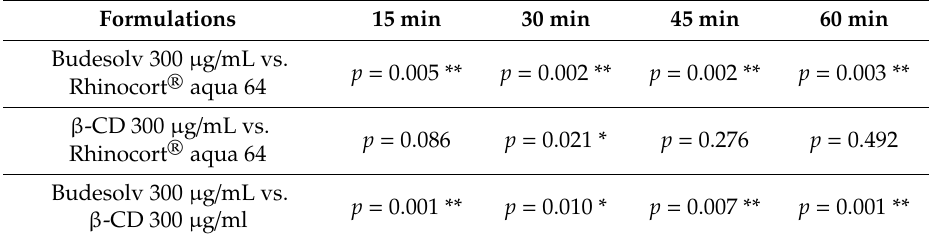
Table 1. Results of the statistical analysis of the permeation of budesonide into porcine nasal mucosa after incubation with di ff erent formulations.